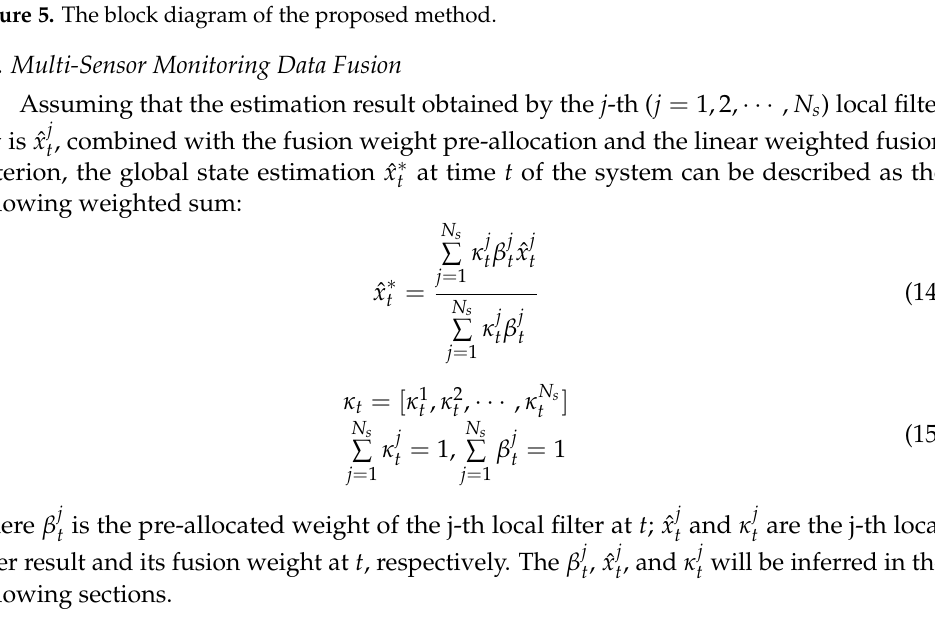
( b ) Figure 3. Wheel Hall speed sensor and installation example: ( a ) wheel Hall speed sensor; ( b ) installation example.